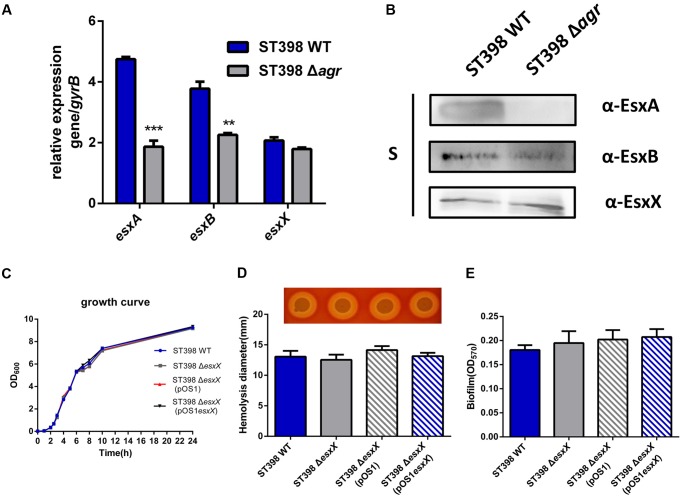
EsxX is not under the control of agr and the role of EsxX in S. aureus ST398 phenotypes.
(A) Gene transcription of esxA, esxB, and esxX and (B) protein expression of EsxA, EsxB, and EsxX in ST398 wild type versus an agr deletion mutant as determined by qRT-PCR and Western blotting. ∗∗p < 0.01; ∗∗∗p < 0.001 (unpaired t-tests). (C) Growth of ST398 wild type versus the esxX mutant. (D) Zones of hemolysis (diameter) due to the wild type strain versus the esxX deletion mutant, the complemented mutant and the deletion mutant harboring a control plasmid. (E) Detection of biofilm formation in wild type strain versus the esxX deletion mutant, the complemented mutant and the deletion mutant harboring a control plasmid.